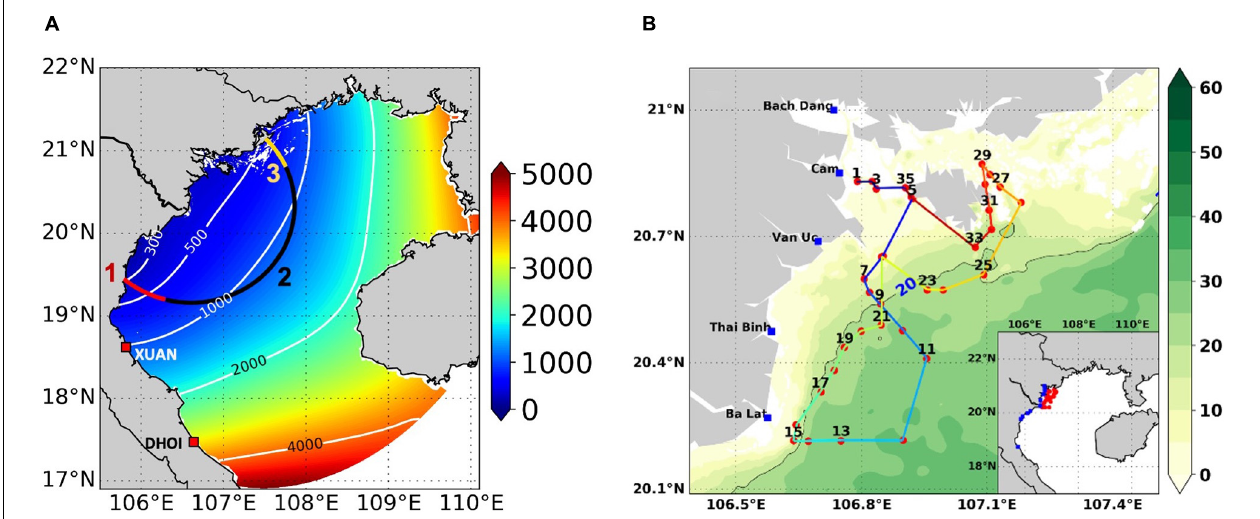
FIGURE 2 | (A) Grid cell size (m). Red squares show the location of HFR antennas. (1, 2, 3): Sections used to calculate the tracer transport. VITEL (B) CTD stations location. Red dots indicate the station locations, while blue points indicate the river mouths’ locations.